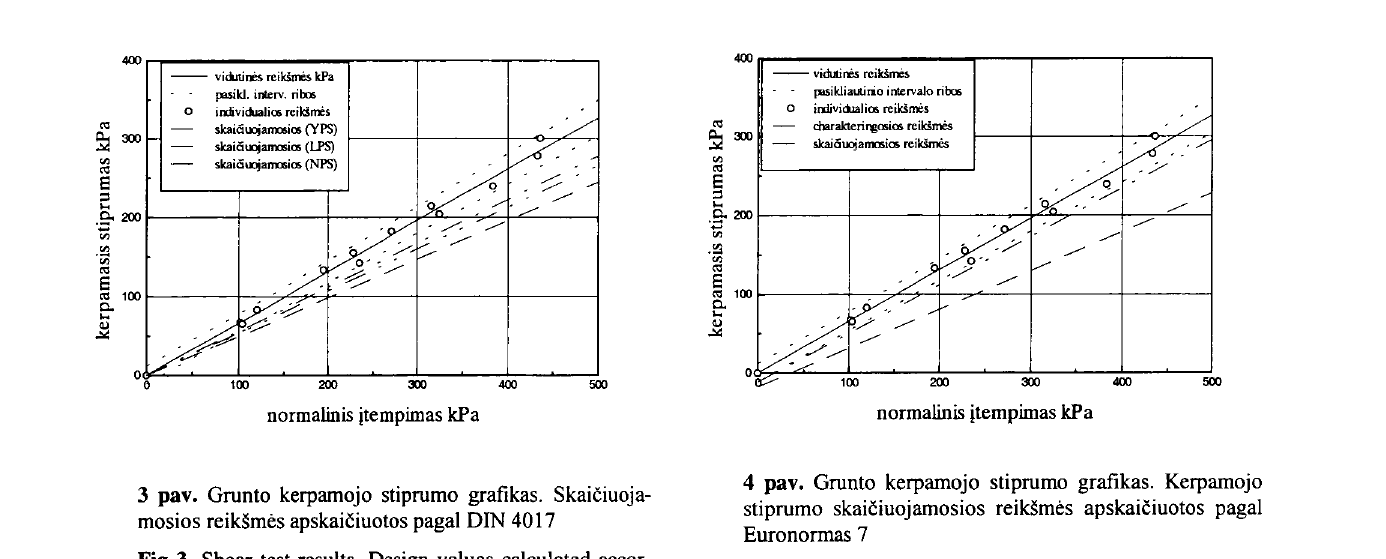
Fig 3. Shear test results. Design values calculated accor